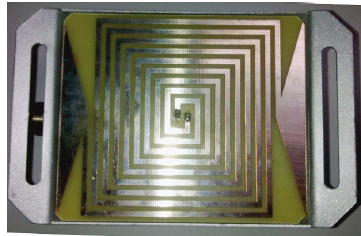
Figure 4: Physical map of the designed antenna.